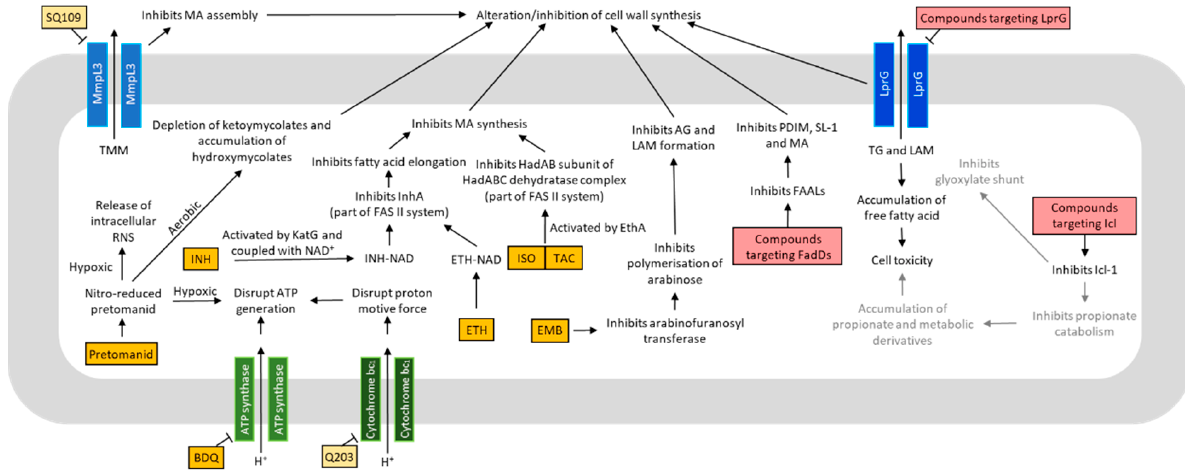
Figure 2. Mechanisms of action of various antituberculosis (anti-TB) drugs and compounds targeting the metabolism of Mycobacterium tuberculosis ( Mtb ). Many anti-TB drugs and compounds target different aspects of metabolism, and consequently lead to bacteriostasis or bactericidal effects. Some anti-TB drugs and compounds may share the same cellular targets. Others may act on different targets, which can affect common metabolic pathway(s). Drugs approved for treatment are colored in orange. Compounds undergoing clinical trials are colored in yellow. Compounds still in in vitro developmental phase are colored in red. Text colored in grey are the proposed mechanisms. Abbreviations: INH = isoniazid; ETH = ethionamide; ISO = isoxyl; TAC = thioacetazone; BDQ = bedaquiline; FadDs = fatty acid adenylating enzymes; ICL = isocitrate lyase; EMB = ethambutol; ATP = adenosine triphosphate; NAD = nicotinamide adenine dinucleotide; LprG = Lipoarabinomannan carrier protein LprG; EthA = flavin adenine dinucleotide (FAD)-containing monooxygenase; HadAB = β -hydroxyacyl-ACP dehydratase HadAB complex; KatG = catalase-peroxidase; FAS II = type II fatty acid synthase; InhA = enoyl-ACP reductase; RNS = reactive nitrogen species; AG = arabinogalactan; TG = triacylglycerol; LAM = lipoarabinomannan; FAAL = fatty acyl AMP ligase; PDIM = phthiocerol dimycocerosates; SL-1 = sulfolipid-1; MA = mycolic